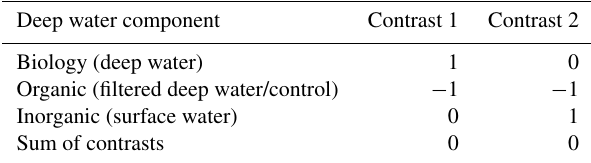
Table 2. Contrast matrix used to compare treatment effects in the linear mixed model applied to the bloom and post-bloom